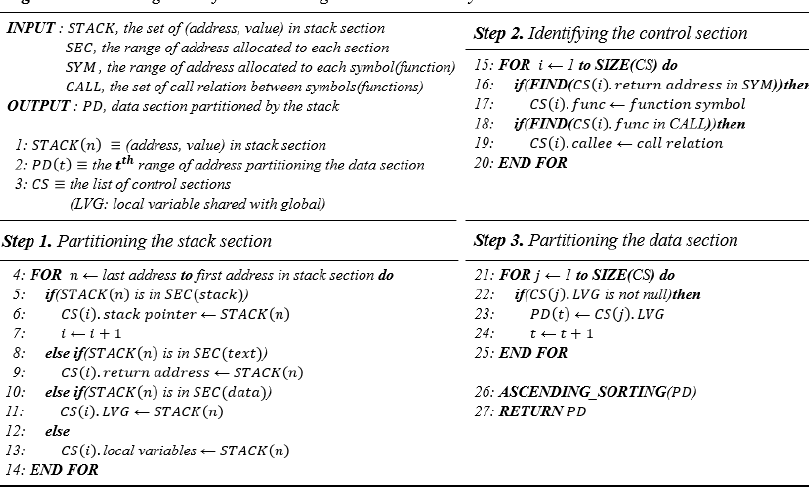
Figure 10. Algorithm for partitioning the data section by the stack.